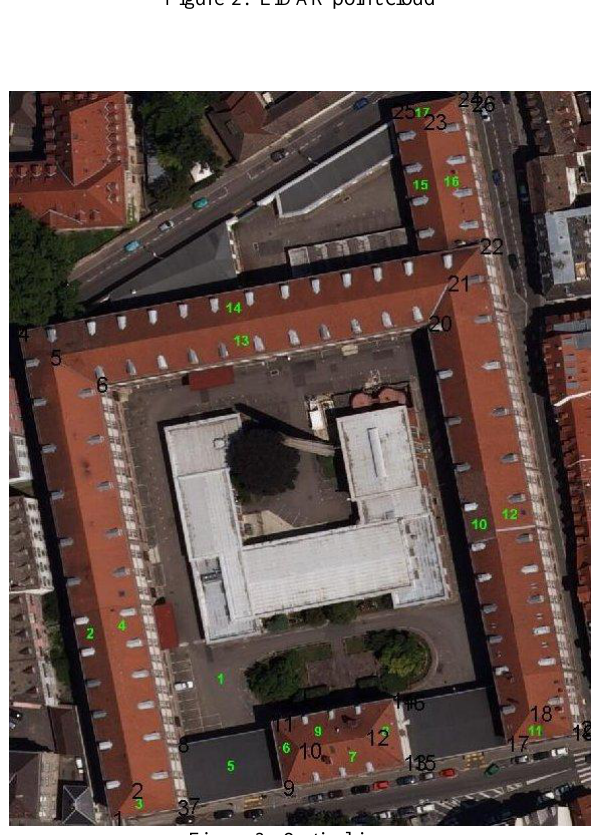
Figure 3. Optical image